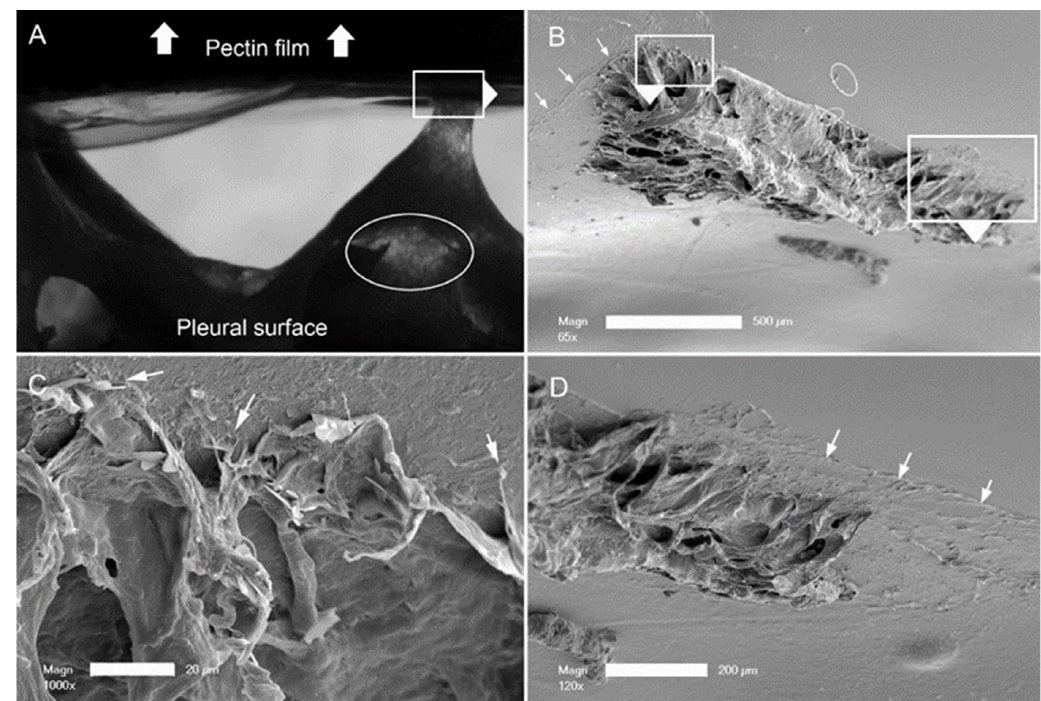
Figure 5. Pectin–glycocalyceal adhesion resulting in submesothelial tissue separation with the result of porcine lung tissue adherent to the pectin film. ( A ) Adhesion assay with a representative example of submesothelial separation, reflected in multiple areas of the lucent tissue (ellipse). The direction of the probe withdrawal is denoted by the white arrow. ( B ) The tissue separation in the subjacent alveoli. Higher resolution images show connections of the central line elements of the lung adherent to the pectin ( C ) and residual areas of pectin–glycocalyceal adhesion can be visualized (( D ), arrows) (( B ), bar = 500 um; ( C ), bar = 20 um; and ( D ), bar = 200 um).